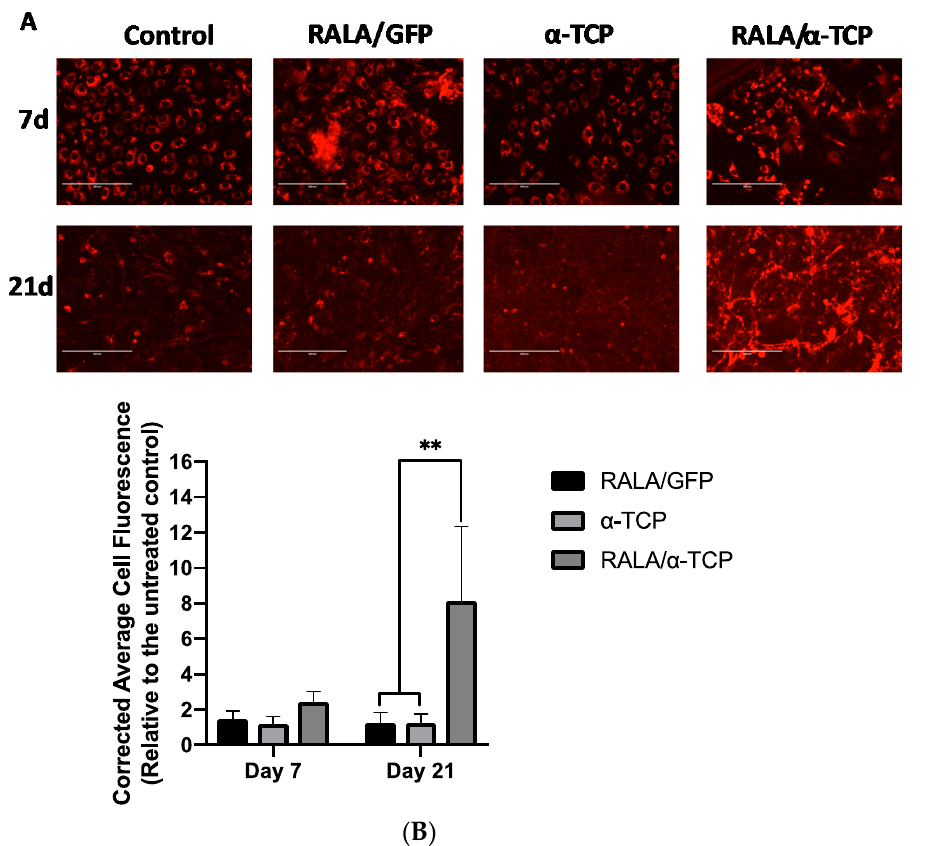
Figure 5. Immunocytochemical analysis for the expression of osteogenic biomarker protein Type I collagen. ( A ) representative fluorescence micrographs of Type I collagen immunofluorescence of MG-63 cell cultures 7 and 21 d post-transfection with RALA / α -TCP NPs in a 24-well plate, evident from the red color. Untreated (control), RALA / pEGFP-N1 (GFP) and α -TCP only groups were also included. (Scale bar = 200 µ m). ( B ) quantitative analysis of cell fluorescence intensity as analyzed using ImageJ and results normalized to the untreated (N = 3 ± SEM) ** = p < 0.01.